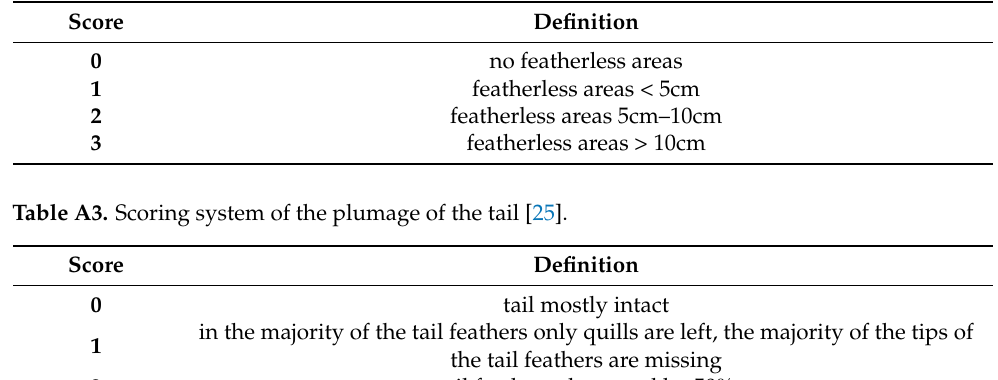
Table A2. Scoring system of the plumage of the back and wings [25].